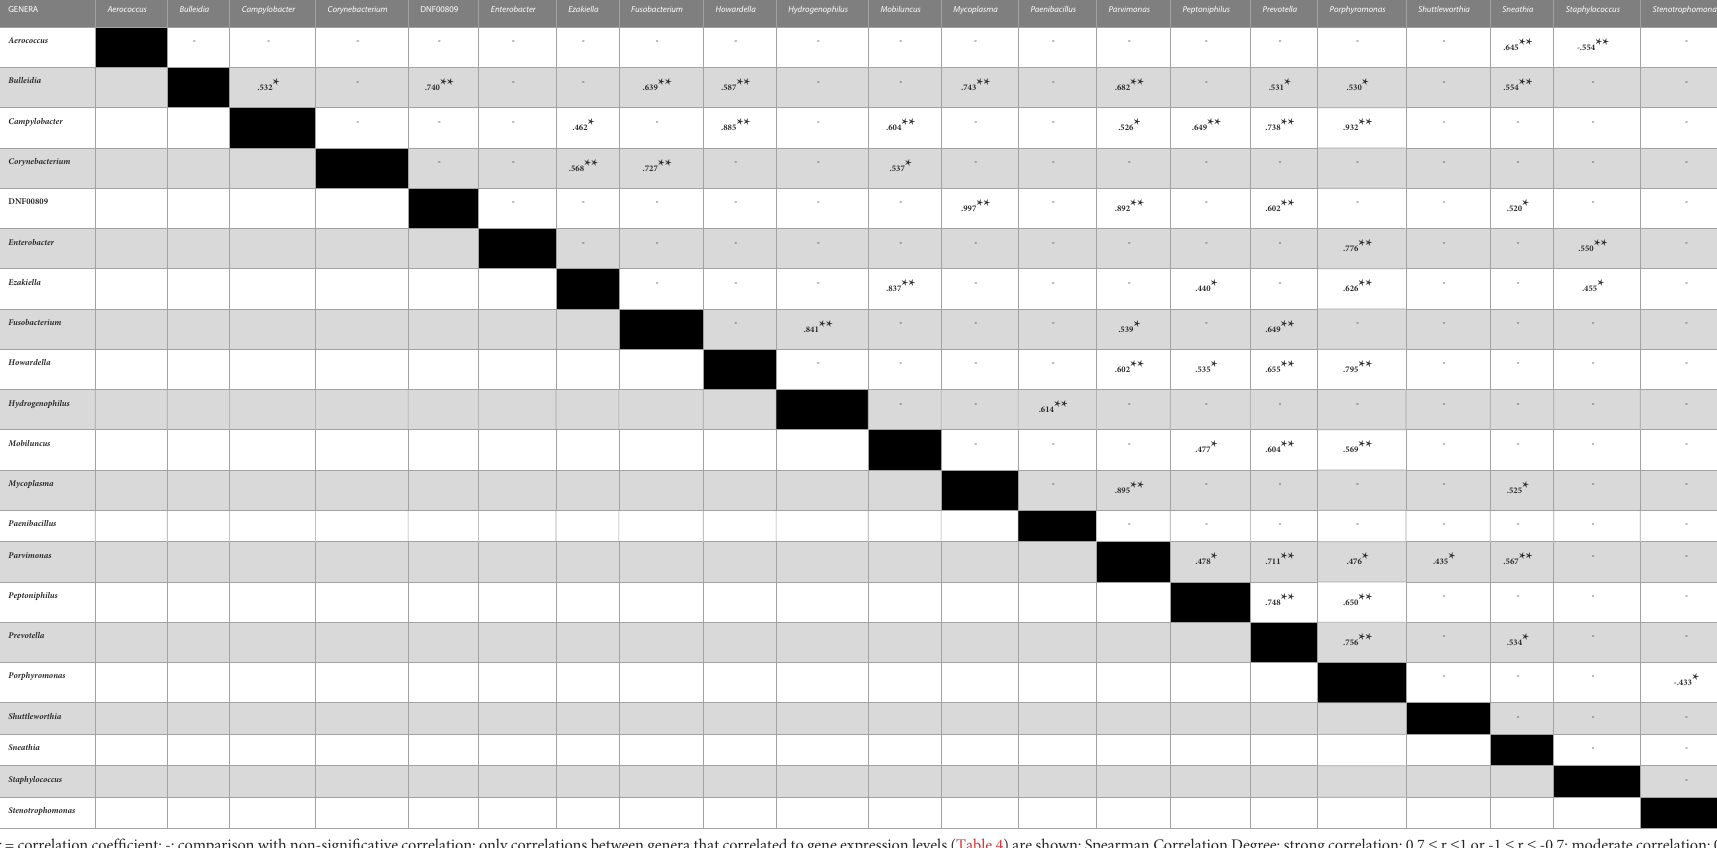
r=correlationcoef fi cient;-:comparisonwithnon-signi fi cativecorrelation;onlycorrelationsbetweengenerathatcorrelatedtogeneexpressionlevels(Table4)areshown;SpearmanCorrelationDegree:strongcorrelation:0.7 ≤ r ≤ 1or-1 ≤ r ≤ -0.7;moderatecorrelation:0.4 ≤ r < 0.7 or -0.7 ≤ r < -0.4; weak correlation: 0 < r < 0.4 or 0.4 < r <0; negative correlation: r < 0. * p < 0.05; ** p < 0.01. Rubrobacter was not presented here as no correlations were found between this genus and other